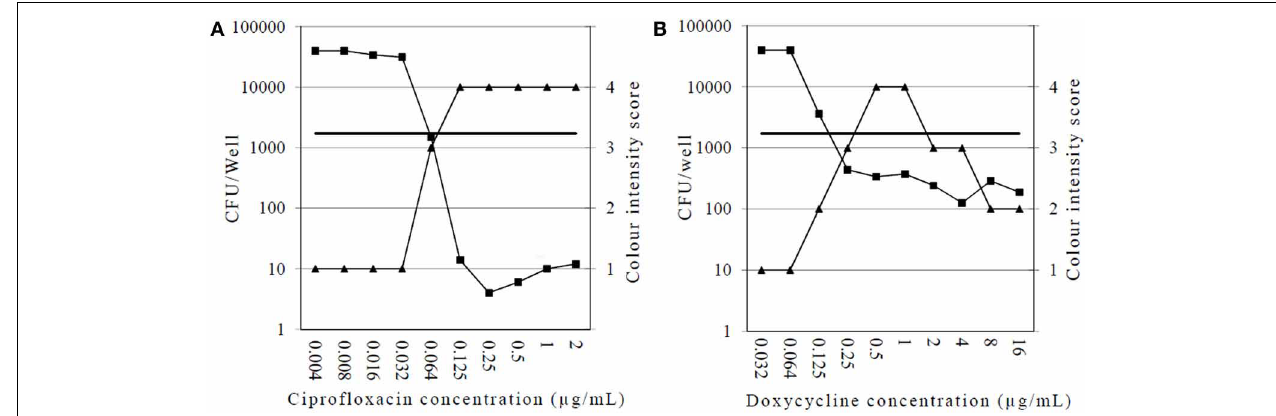
FIGURE 2 | Comparison of results obtained with the CFU enumeration and dye uptake assays for intracellular activity of ciprofloxacin (A) and doxycycline (B) against F. tularensis subsp. holarctica stain Ft6. Squares,